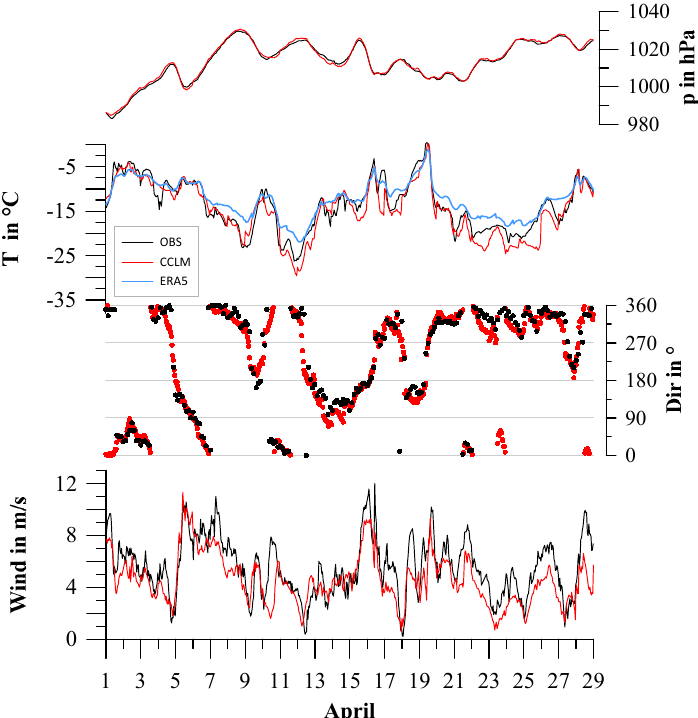
Figure 3. Pressure and 2 m temperature ( upper panels), and 10 m wind speed and direction ( lower panels) for the period 1 to 29 April 2019 for the observations (1 h values (3 h values for wind direction), black) and CCLM simulations (1 h values, red). For 2 m temperature, ERA5 data are shown as a blue line.